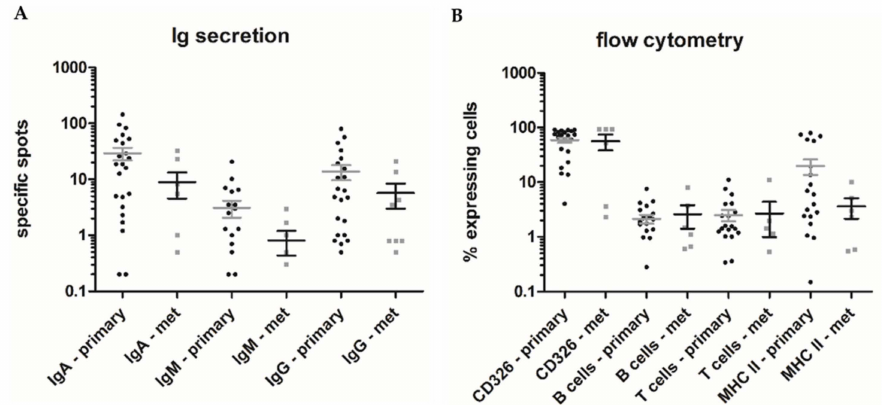
Figure 2. Comparison of primary and metastatic CRC samples. ( A ) Comparison of Ig secreting cells from primary CRC tumors and CRC-metastases. Numbers of IgA, -M, and -G secretors as assessed by FluoroSpot analyses are depicted for CRC tumors (black square) and CRC metastases (grey circle). ( B ) Comparison of tumor cell suspension composition from primary CRC tumors and CRC-metastases. Expression levels of CD326, B cells (CD19 / 20 / 21), T cells (CD3), and antigen-presenters (MHC II) as assessed by flow cytometry are depicted for CRC tumors (black square) and CRC metastases (grey